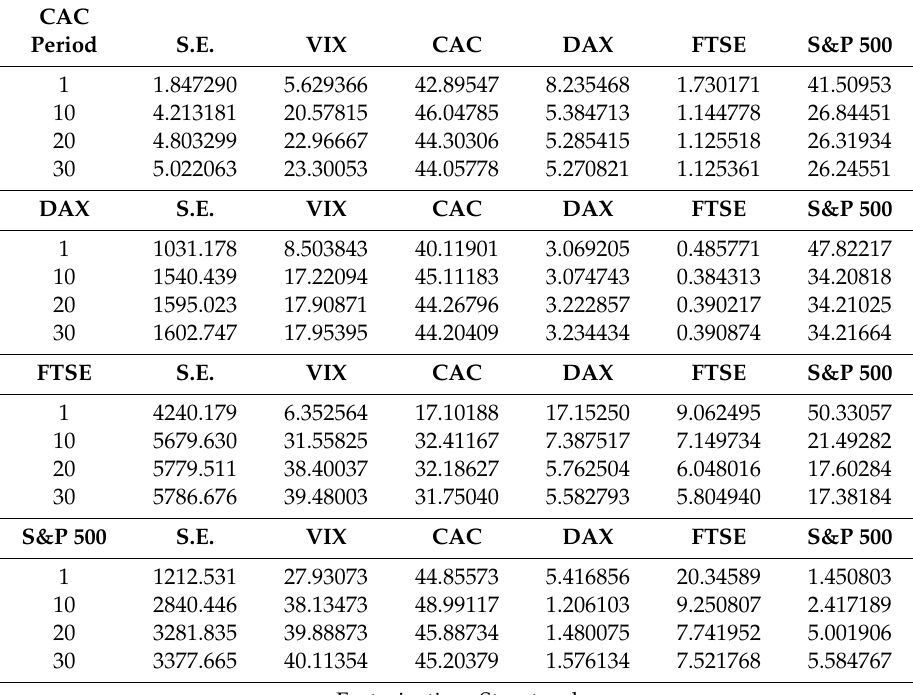
Table 3. Percentage of equity index volatility forecast error variations explained by VIX and